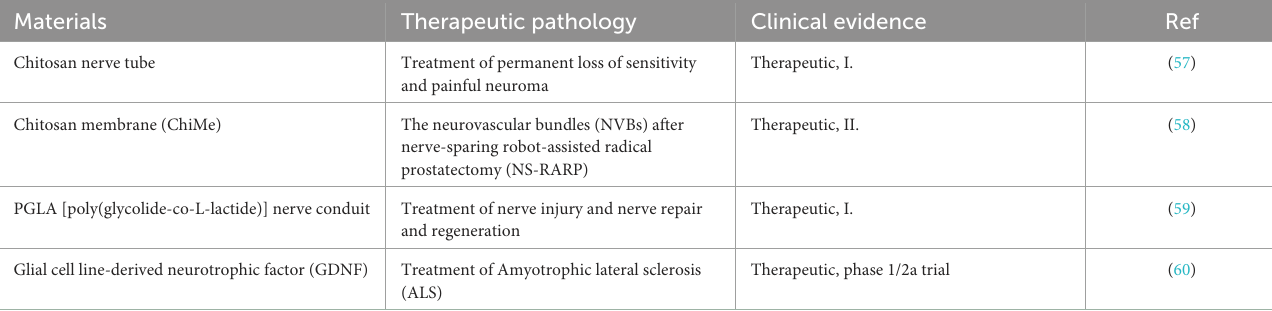
TABLE 2 Summary of clinical trials of existing materials.